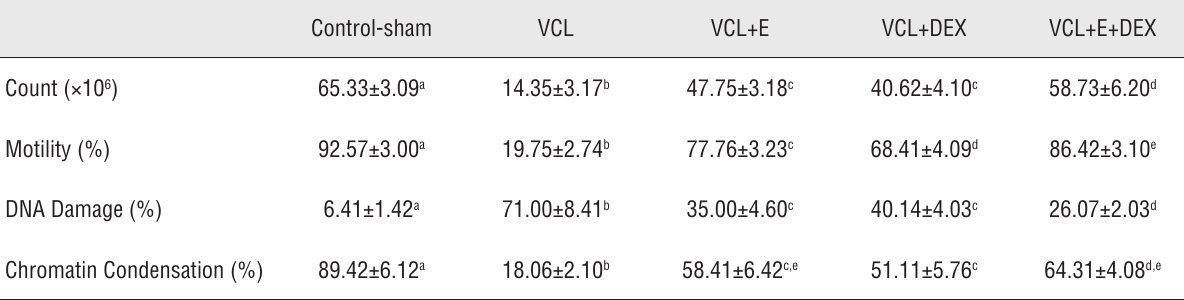
Table 4 - Regulating effect of VitE and DEX on VCL-changed sperm parameters; all data are given as Mean±SD